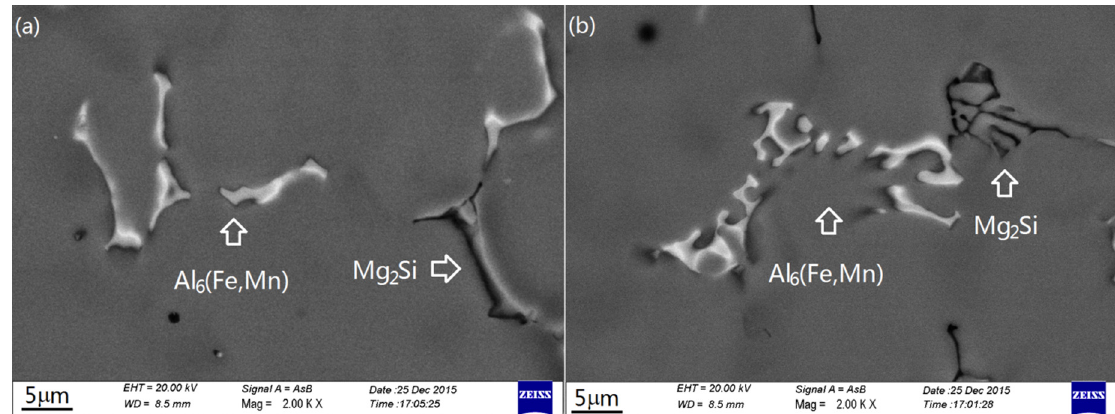
Figure 5. High magnification images of the intermetallics ( a ) Alloy I ‐ 4; ( b ) Alloy II ‐ 1.